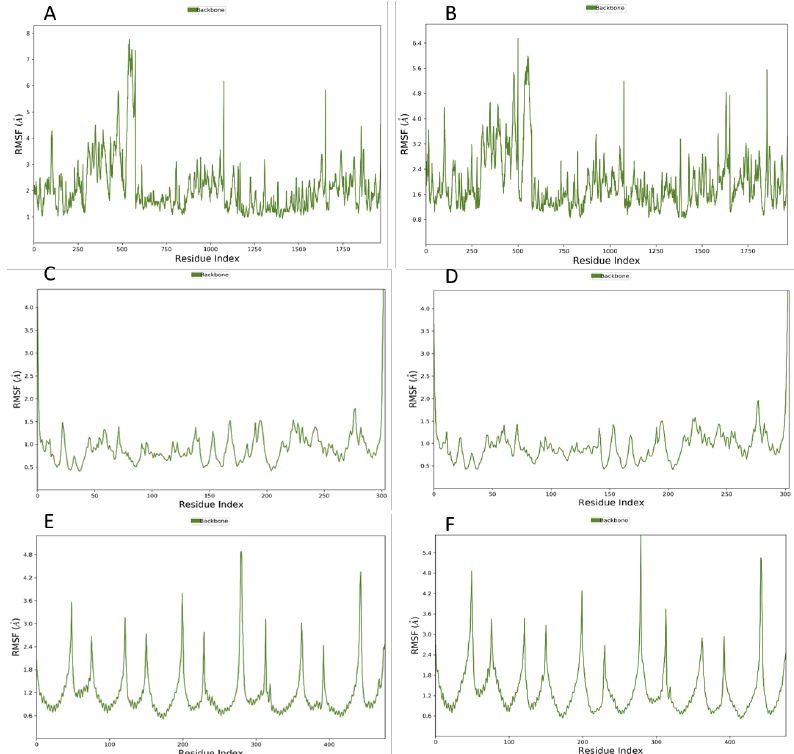
Figure 4. Protein root means square fluctuation (RMSF). ( A , B ): Nintedanib and Baricitinib on ACE2 Protein, PDBID: 6M1D; ( C , D ): Nintedanib and Darunavir on M pro , PDBID: 5R82; ( E , F ): Nintedanib and Quercetin Spike Protein. PDBID: 1ZV8.